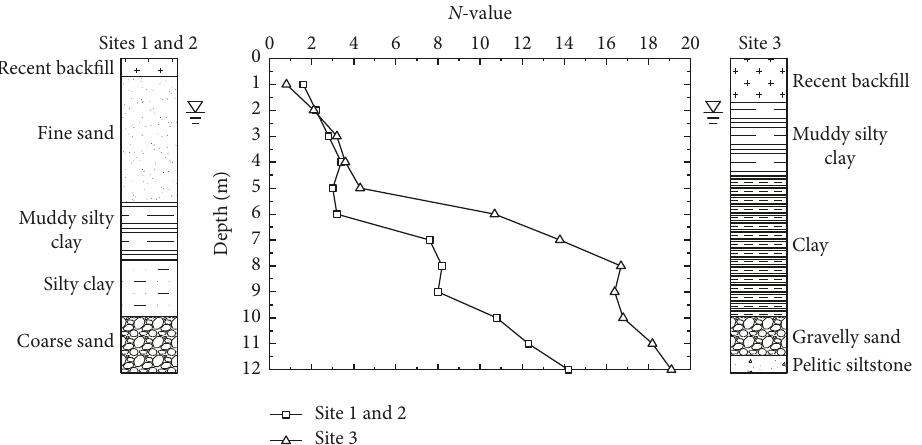
Figure 3: Soil layers and 𝑁 -value versus depth.